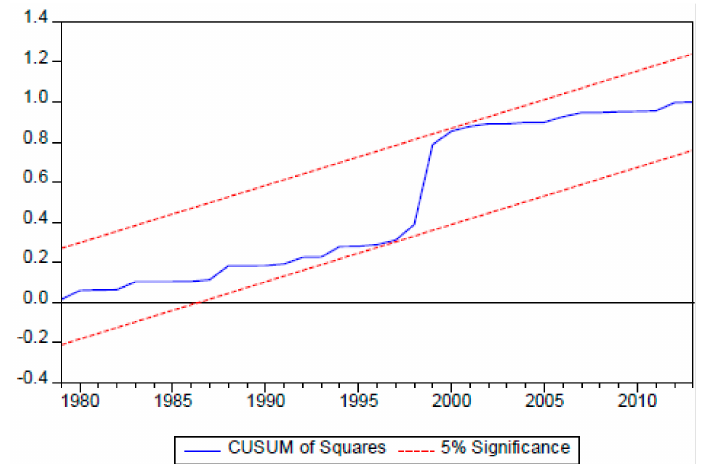
Figure 8. Plot of cumulative sum squares of recursive for residuals for Iran.